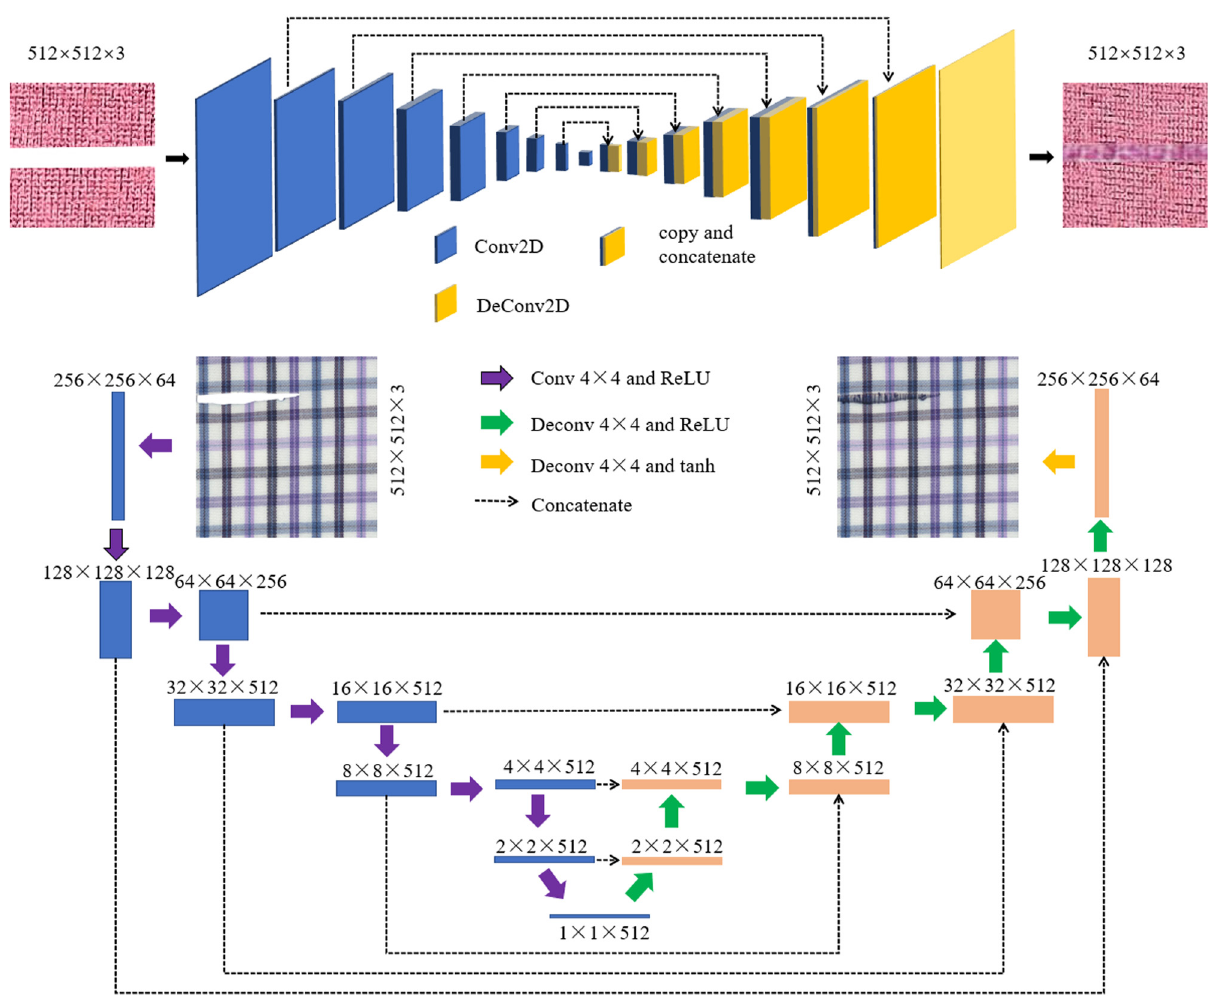
Figure 2: The generator network